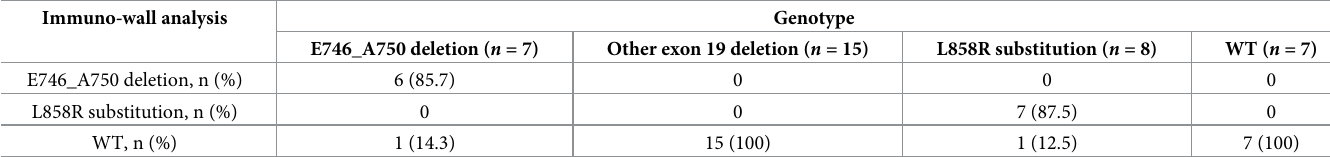
Table 1. Genotype analysis of immuno-wall